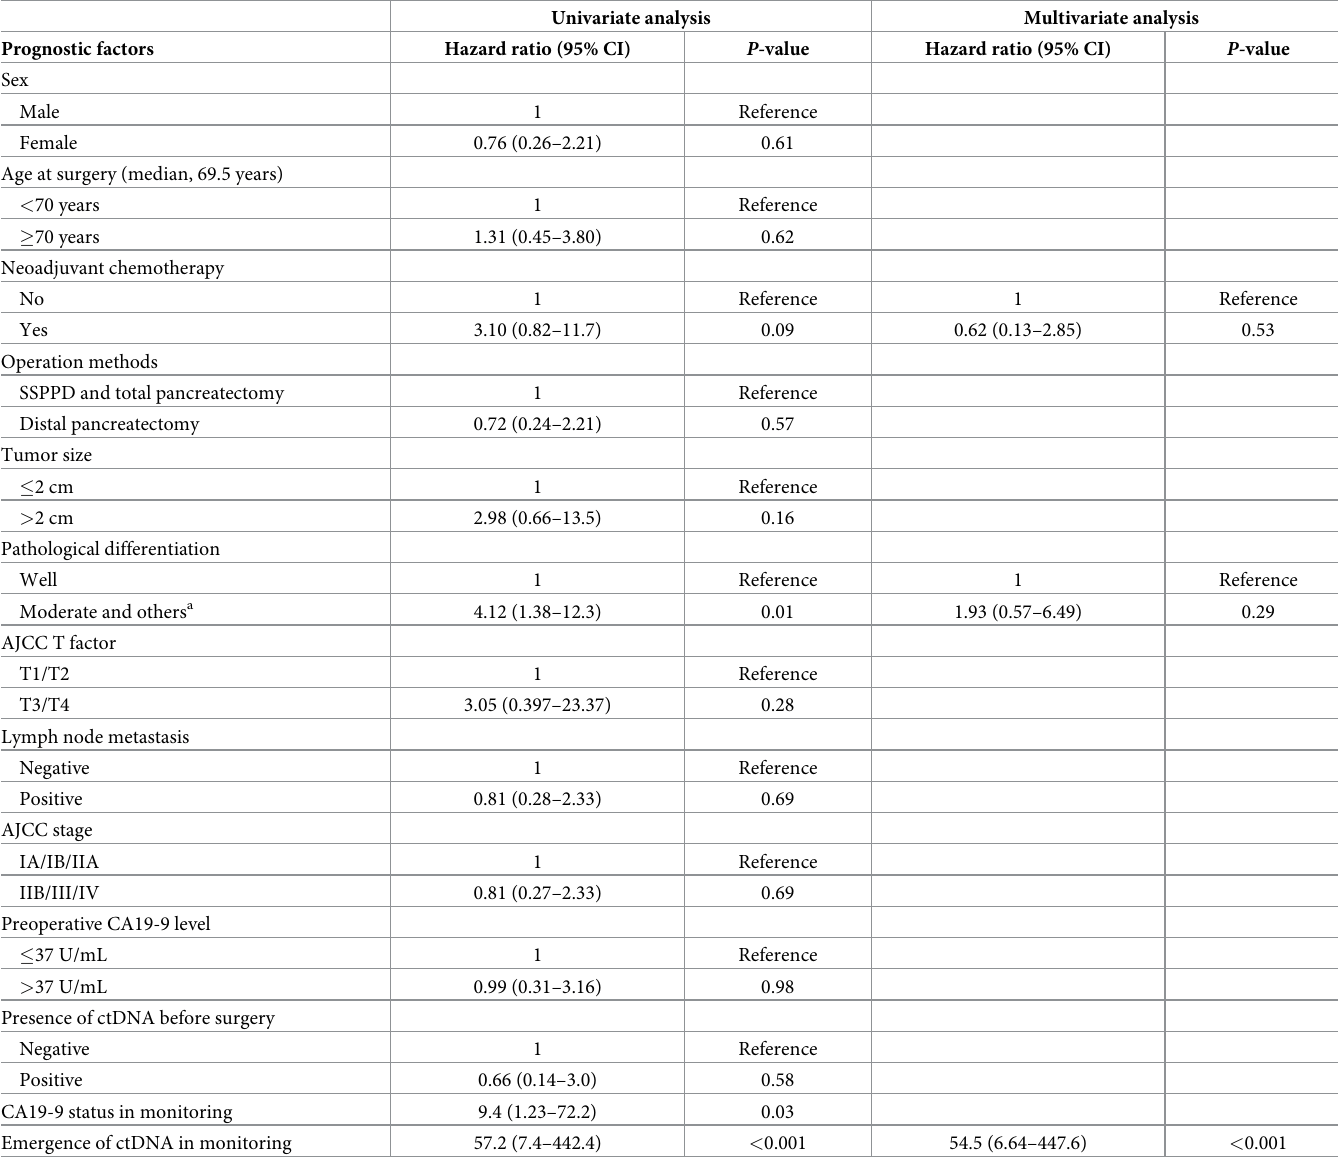
Table 1. Univariate and multivariate analyses of overall survival in patients who underwent